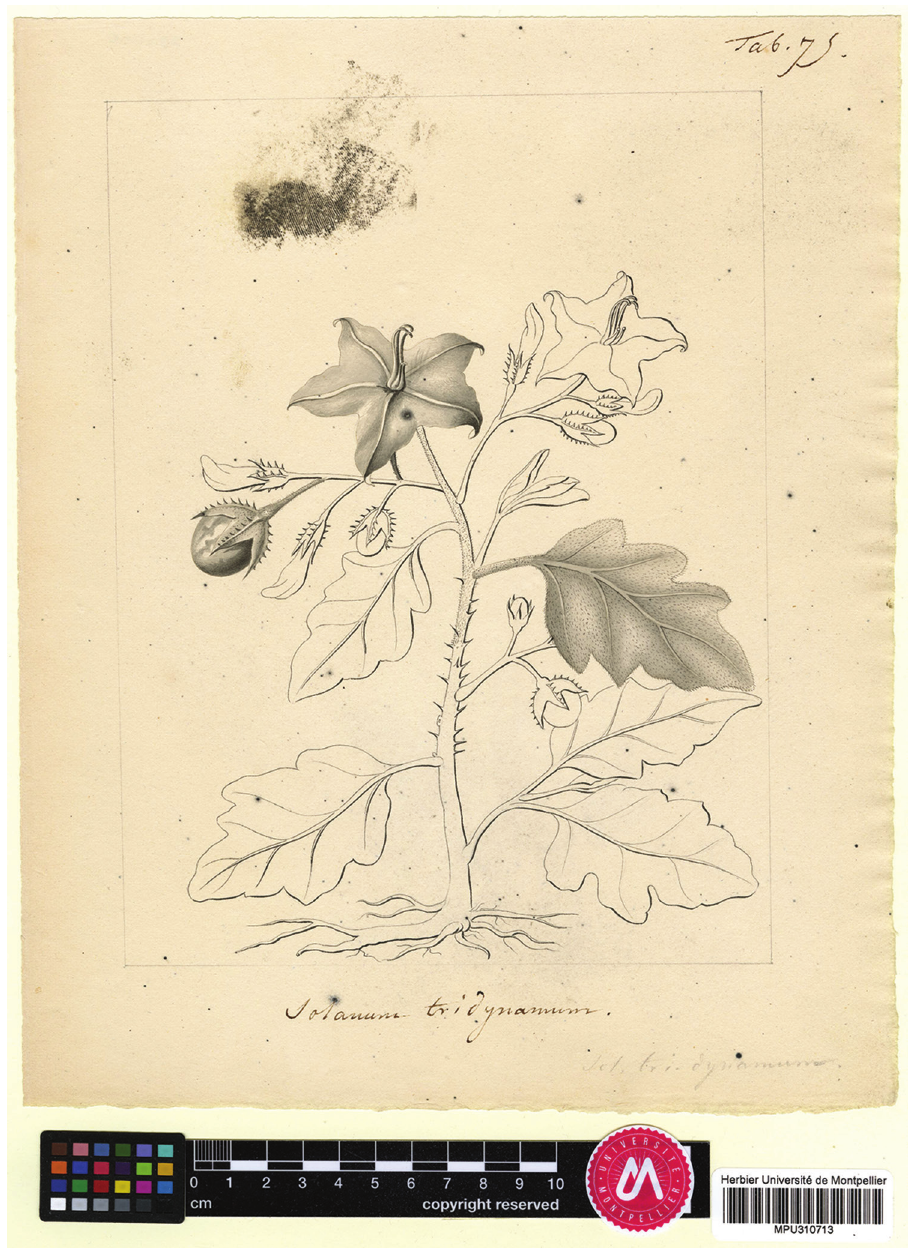
Figure 11. Lectotype of S. tridynamum Dunal. Unpublished drawing by T.F. Node-Véran (1773–1852) based on an illustration of Sessé and Mociño (MPU310713). Reproduced with permission of the Univer- sité de Montpellier – Herbier MPU (Service de Patrimoine Historique); copyright Université de Montpel- lier – Herbier MPU